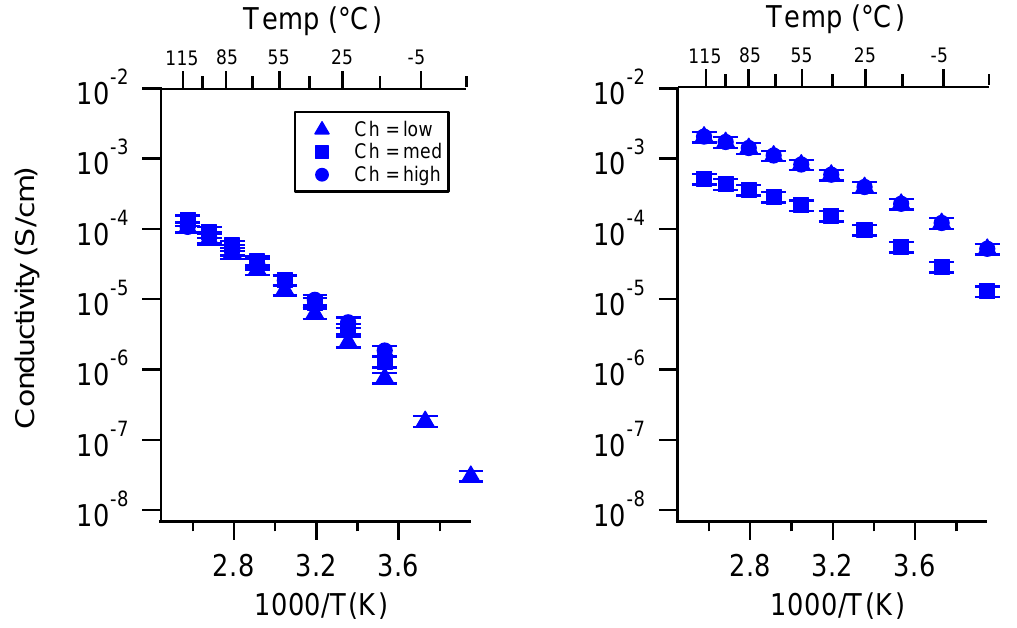
Figure A19. Conductivity as a function of charge density for PEGDMA1000_SSNa (left) and PTHFDA1000_STFSINa (right) SIPEs swelled with ECPC. Temperatures ranged from − 20 °C to 115 °C.